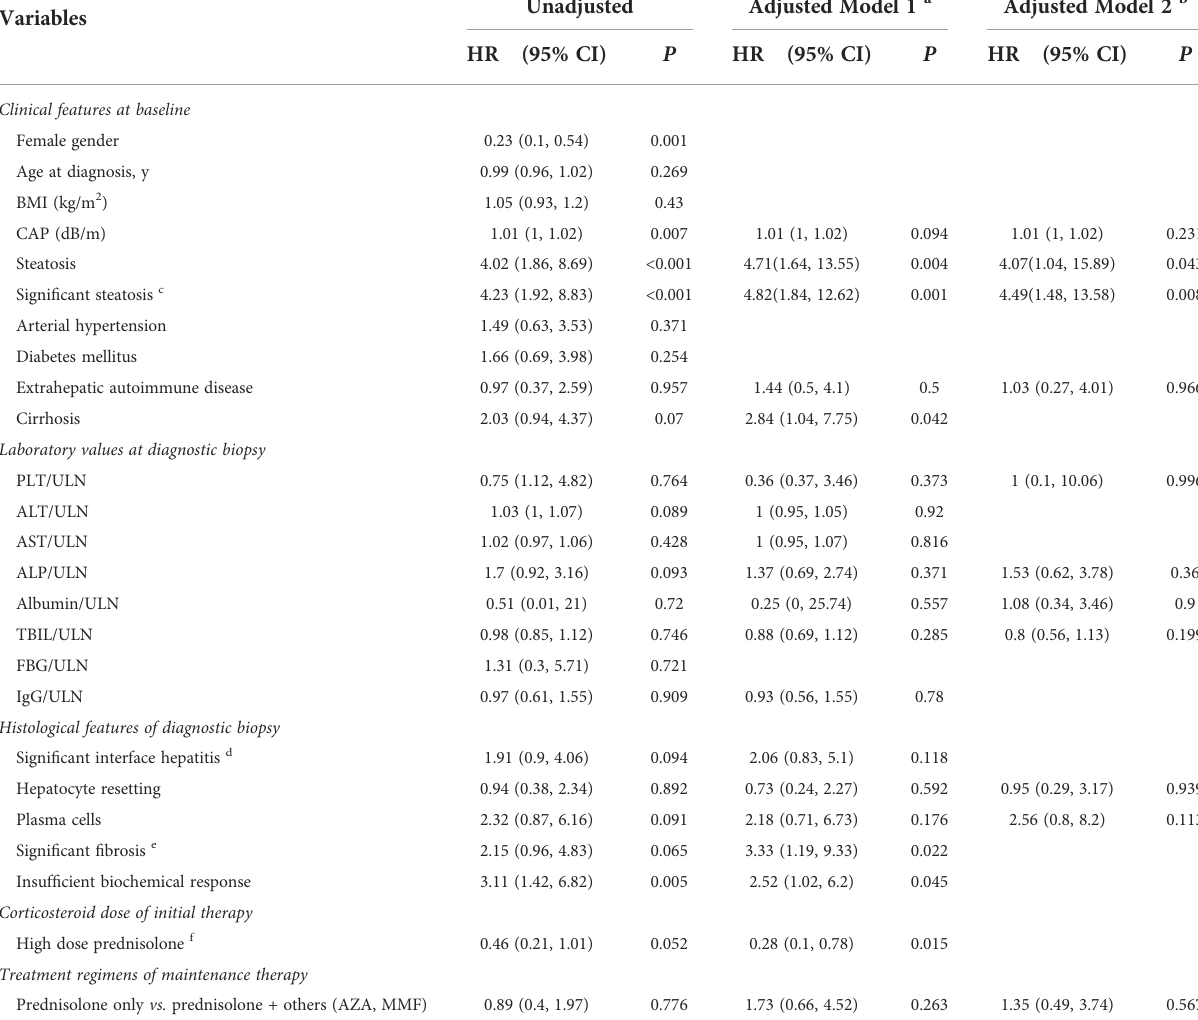
TABLE 4 Univariable and multivariable logistic regression analyses revealed the impact of hepatic steatosis on the risk of adverse outcomes.